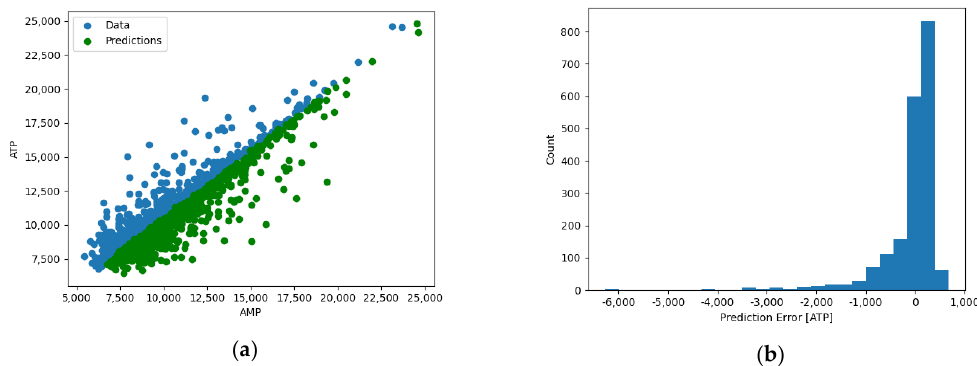
Figure 6. DNN predictions and errors for DRG 178: ( a ) results of the predictions ( b ) errors count. To have a better understanding and compare the performance of both Neural Net- works, in Table 3, a comparison between both models in terms of their accuracy and time spent for every DRG can be seen. Table 3. Perceptron Neural Network results vs. DNN results.